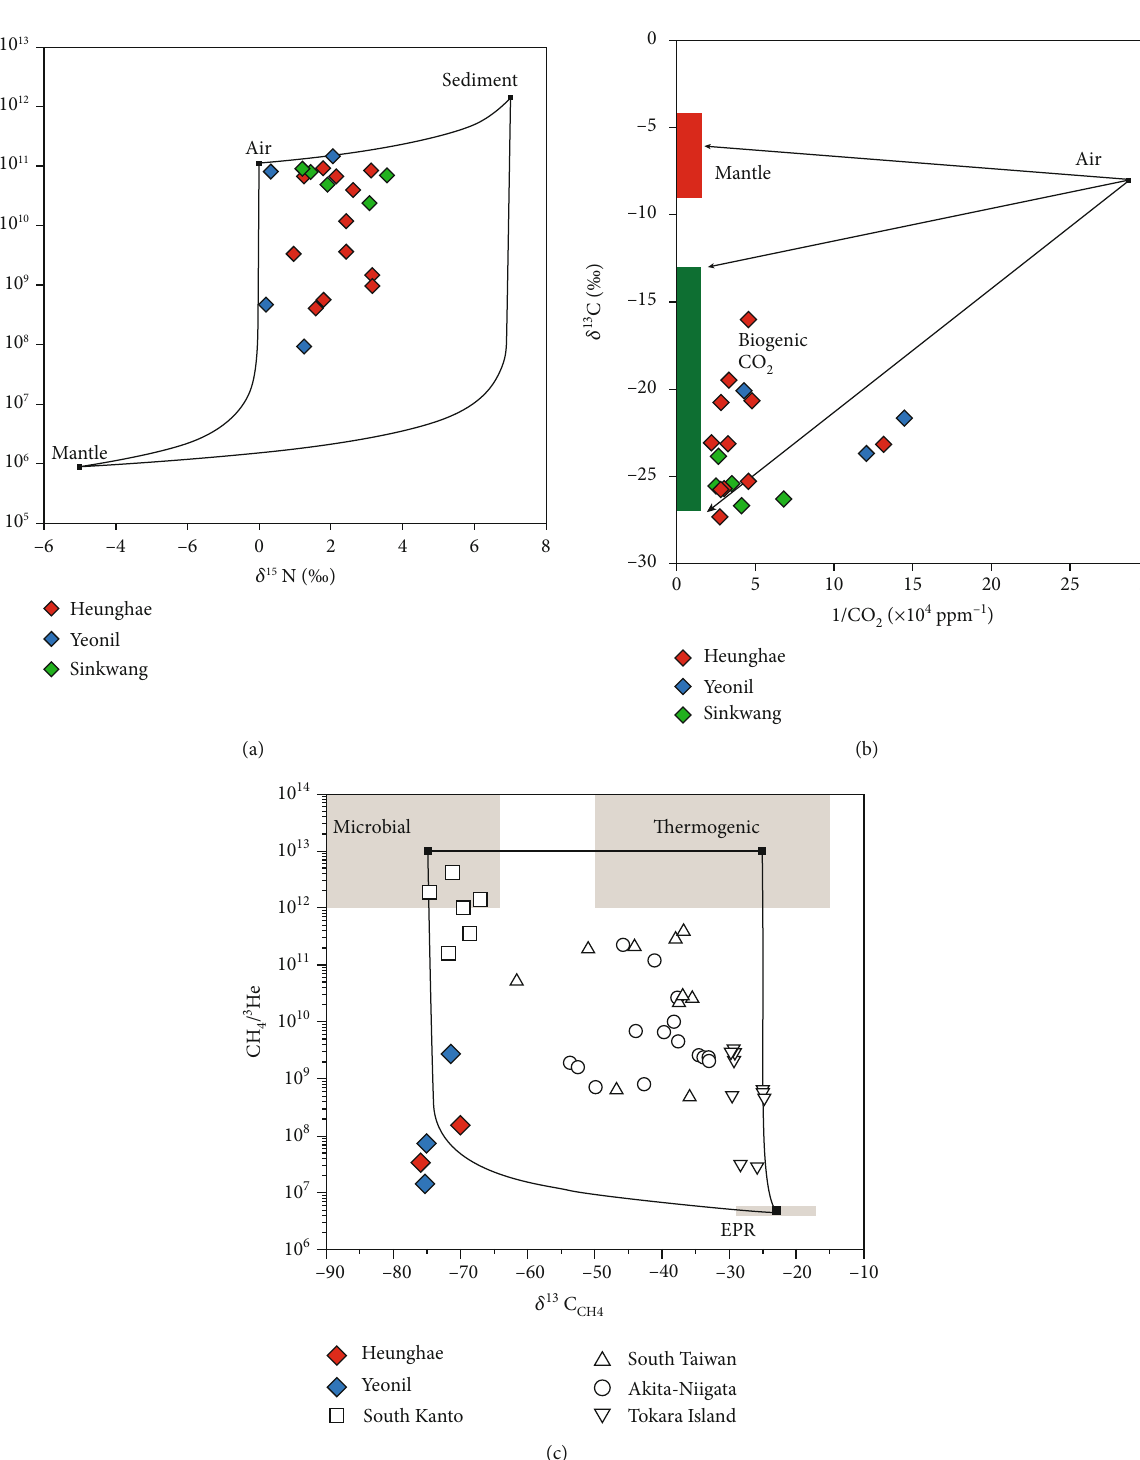
versus 1/CO 2 2 area ranges 2